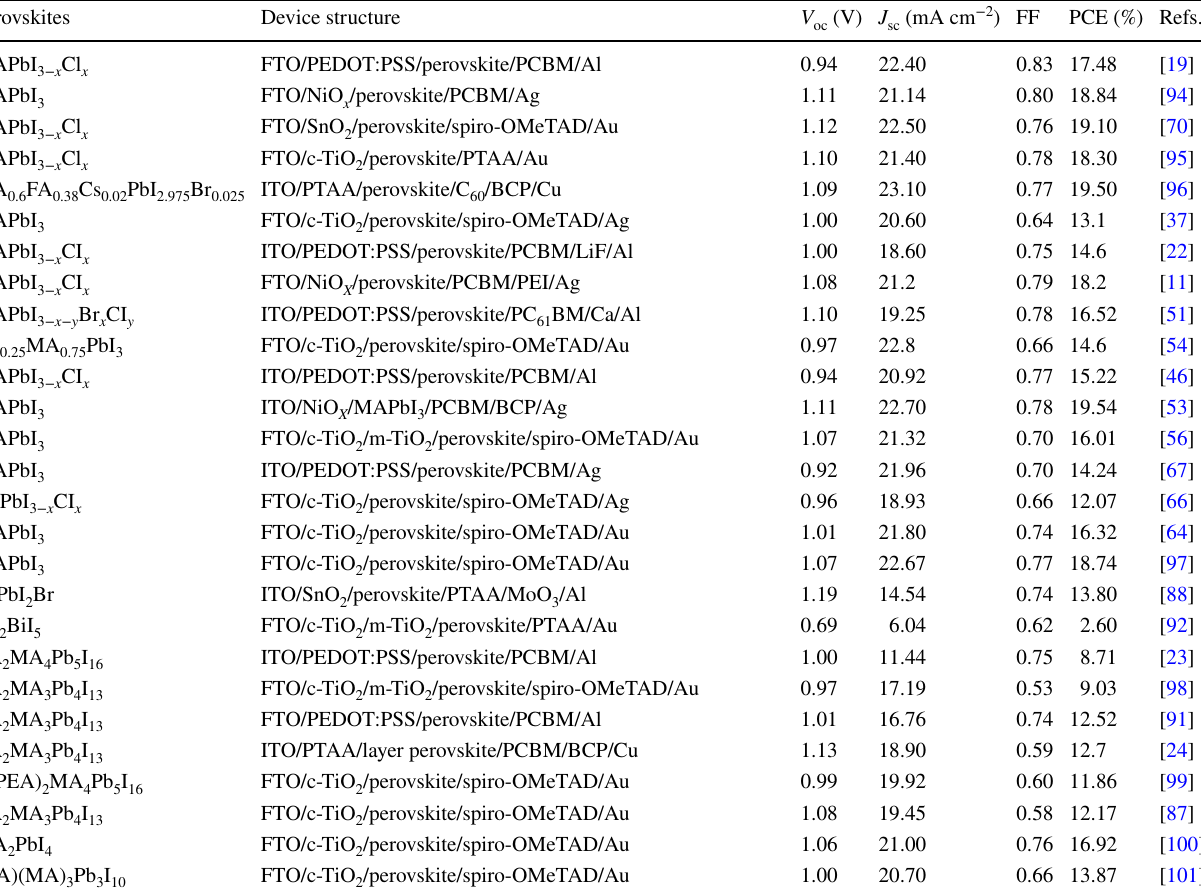
Table 1 Summary of photovoltaic parameters for PSCs with hot-casting technique